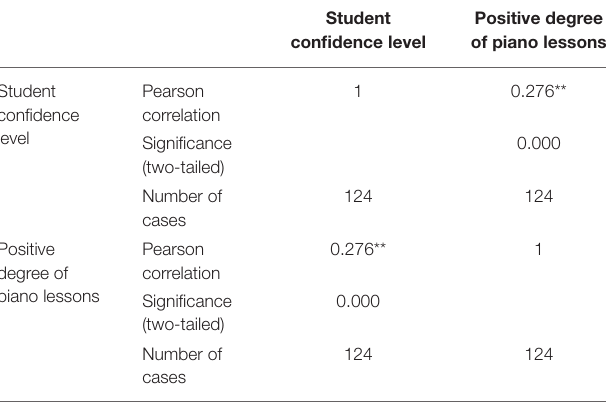
TABLE 4 | Correlation analysis between confidence level of students and piano learning activeness.